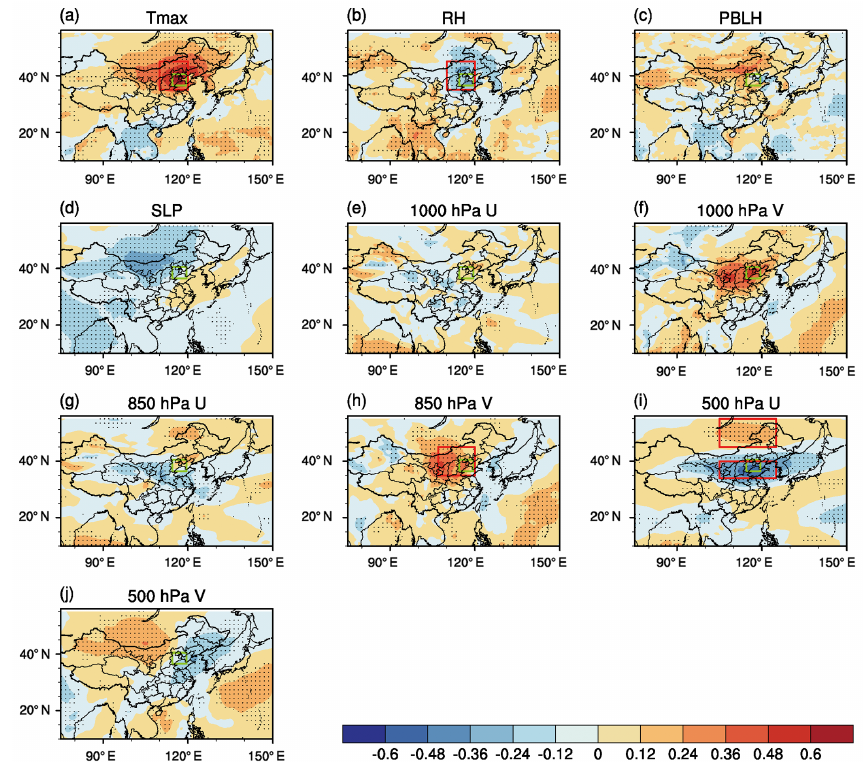
Figure 5. Correlation coefficients for the months of May to July of 2014–2017 between daily regional mean MDA8 O 3 concentrations in North China and daily mean (a) 2m Tmax at the surface, (b) RH at the surface, (c) planetary boundary layer height, (d) surface level pressure, (e) meridional winds at 1000hPa, (f) zonal winds at 1000hPa, (g) meridional winds at 850hPa, (h) zonal winds at 850hPa, (i) meridional winds at 500hPa and (j) zonal winds at 500hPa in Asia. Correlation coefficients with black dots are statistically significant above the 95% confidence level. The red rectangles in (a) , (b) , (h) and (i) denote the regions for calculating index_Tmax, index_RH, index_V850 and index_U500, respectively (see Sect. 4.3). The green rectangle indicates the region of North